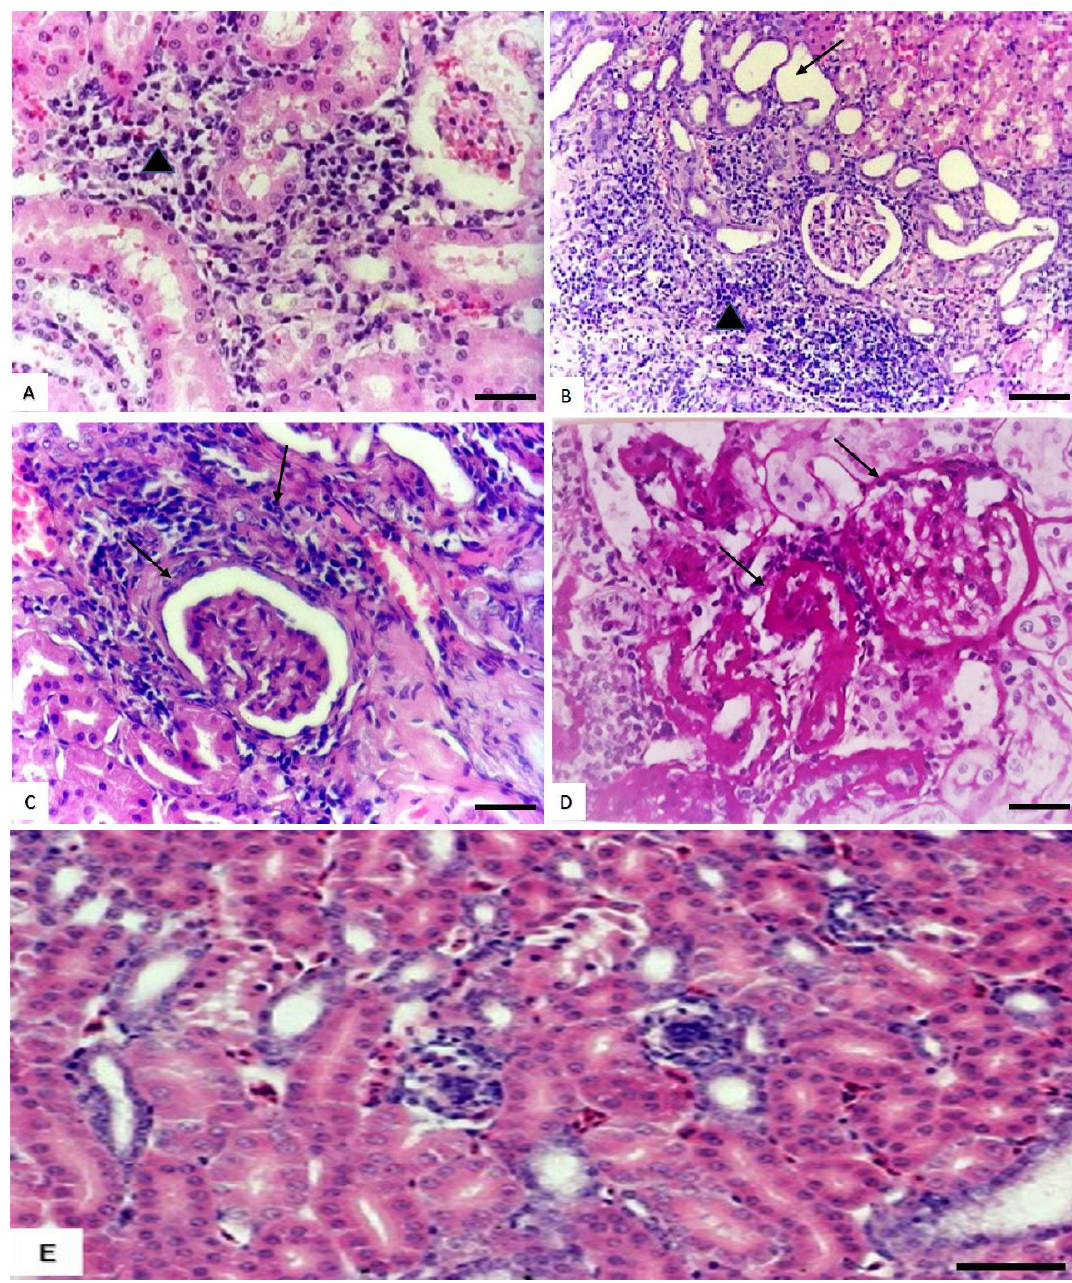
Figure 2. Effect of cymoxanil on the kidneys. ( A ) Kidneys of rats treated with low and medium dose showing slight interstitial nephritis (triangle) with intertubular infiltration of mononuclear cells and degeneration of renal tubule epithelial lining (H&E, bar = 50 µm). ( B ) Kidneys of rats treated with high dose showing severe interstitial nephritis (triangle) and dilatation of the adjacent renal tubules (arrow) (H&E, bar = 100 µ m). ( C , D ) Kidneys of rats treated with high dose showing thickening and sclerosis of the Bowman capsule and the surrounding renal tubules (arrows) (H&E and PAS respectively, bar = 50 µ m). ( E ) Kidneys of control rats showing renal tubules with intact lining epithelium and glomeruli (H&E, bar = 50 µ